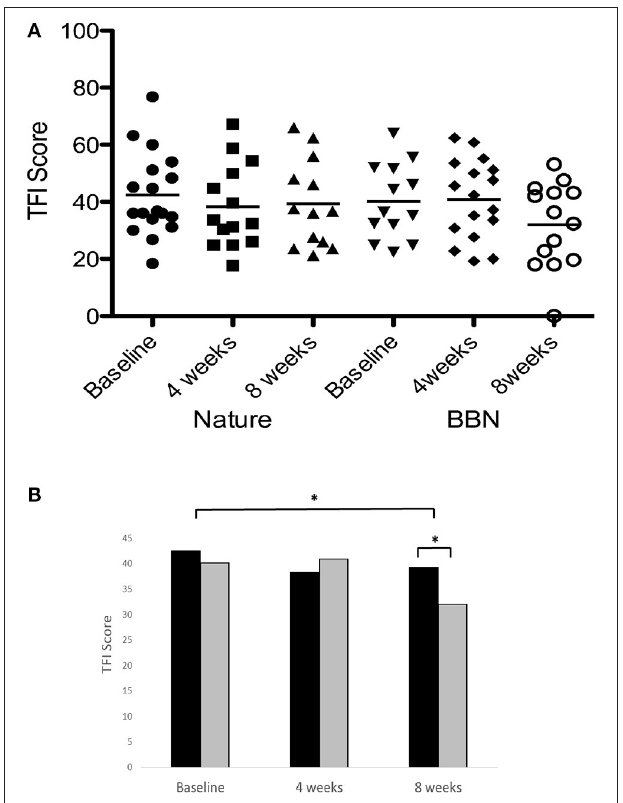
FIGURE 6 | (A) Individual TFI scores of participants at baseline, at 4 weeks follow-up and at 8 weeks follow-up following administration of BBN and nature sound stimuli. Horizontal lines represent average TFI scores. (B) Average TFI scores of participants at baseline (filled circles for nature sounds; inverted triangles for BBN), at 4 weeks follow-up (squares for nature sounds; diamonds for BBN) and at 8 weeks follow-up (triangles for nature sounds; open circles for BBN) following administration of BBN (black) and nature (gray) sound stimuli. The significant difference is indicated by * p < 0.05. Error bars represent ± one standard error.